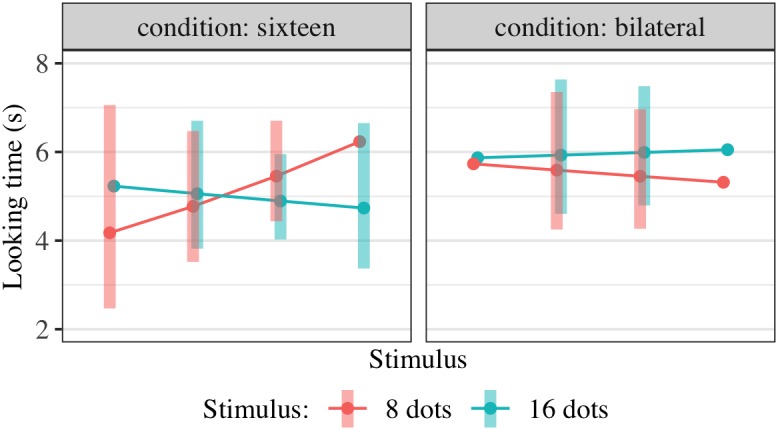
Interaction plot of estimated marginal means across combinations of familiarization condition and stimulus type, based on the linear mixed-effects model fitted for Experiment 3. Shaded error bars show 95% confidence intervals.